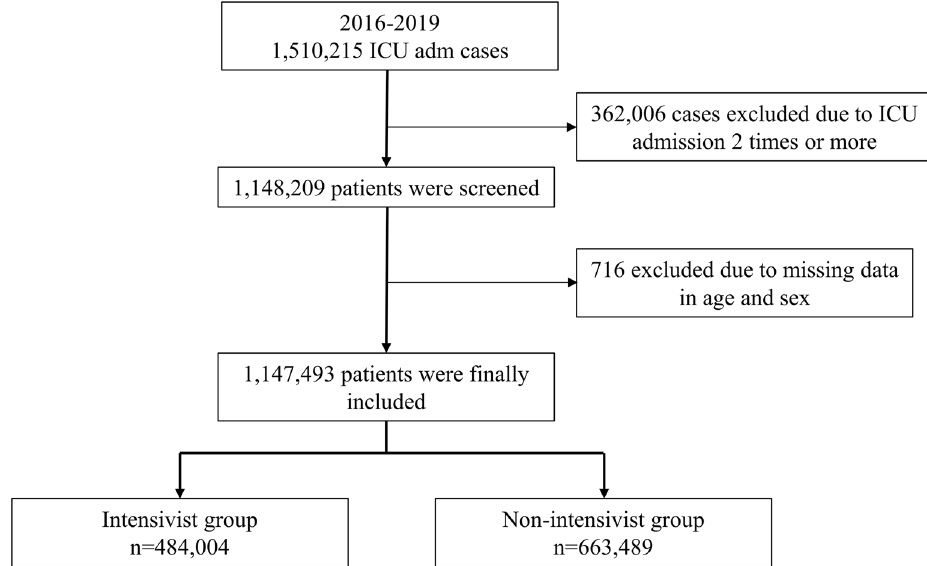
Fig. 1 Flowchart depicting the patient selection